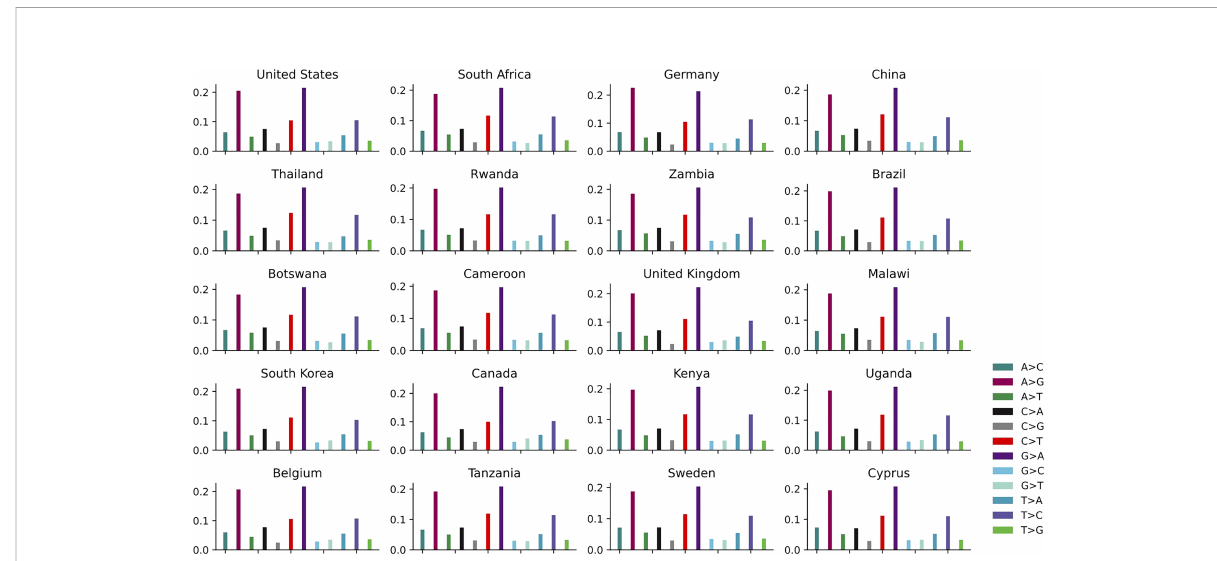
FIGURE 4 The distribution of 12 non-unique mutations in the top 20 countries with the larger number of genomes.